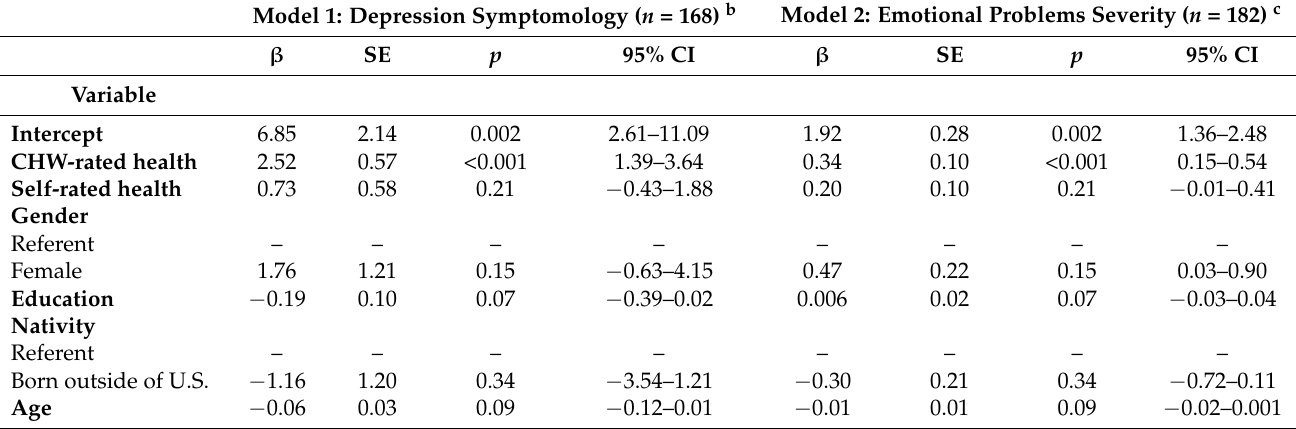
Table 2. Multilevel linear models examining depression symptomology and emotional problems severity a